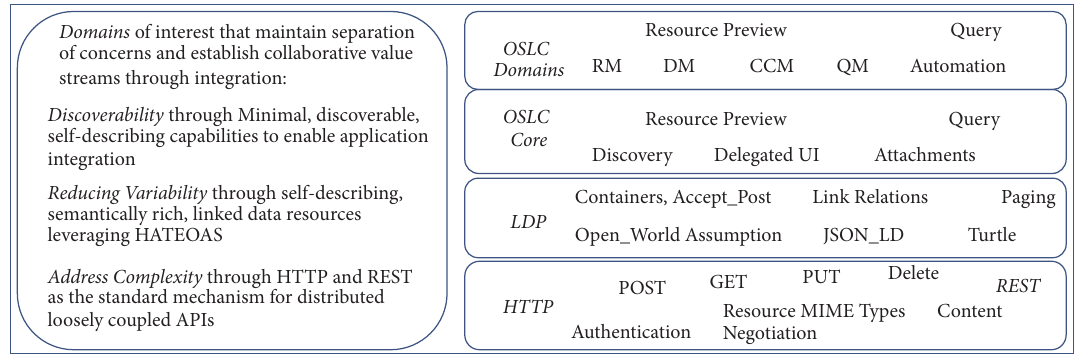
Figure 2: OSLC core concepts and relationships (OASIS OSLC Lifecycle Integration Core: June